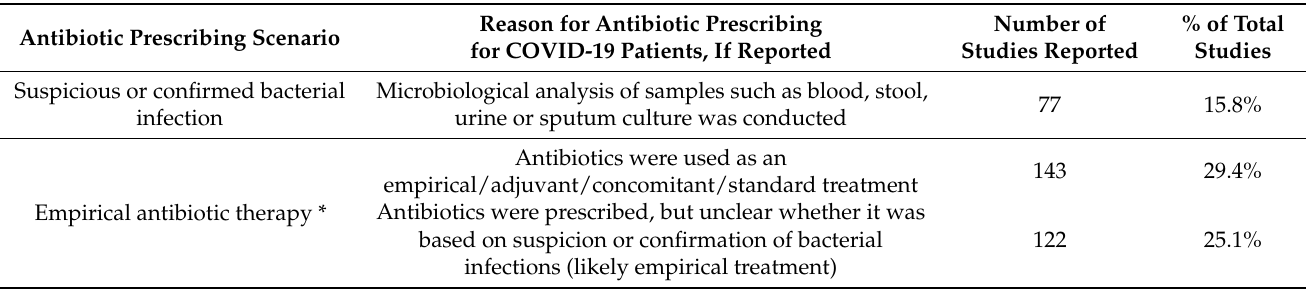
Table 8. Frequent antibiotic prescribing scenarios in COVID-19 patients in the selected studies. Antibiotic Prescribing